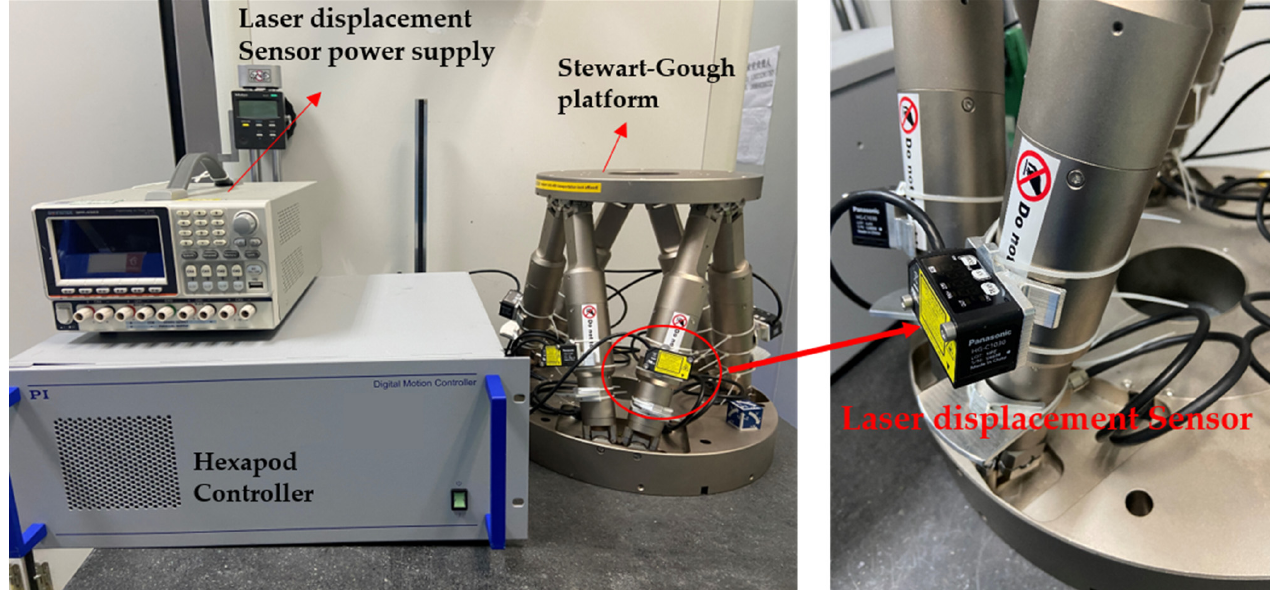
Figure 10. The experimental platform to verify the SA–PSO forward solution. Table 9. The coordinates of the joints of the Stewart–Gough platform H-850.